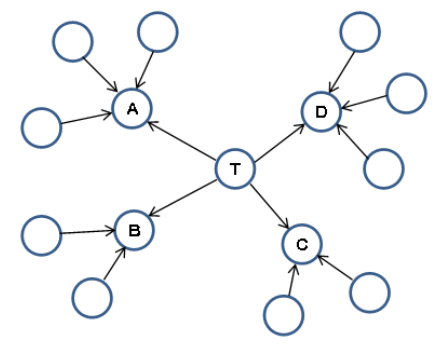
Figure 3. An illustration example of the proposed definition of LSI (Local Social